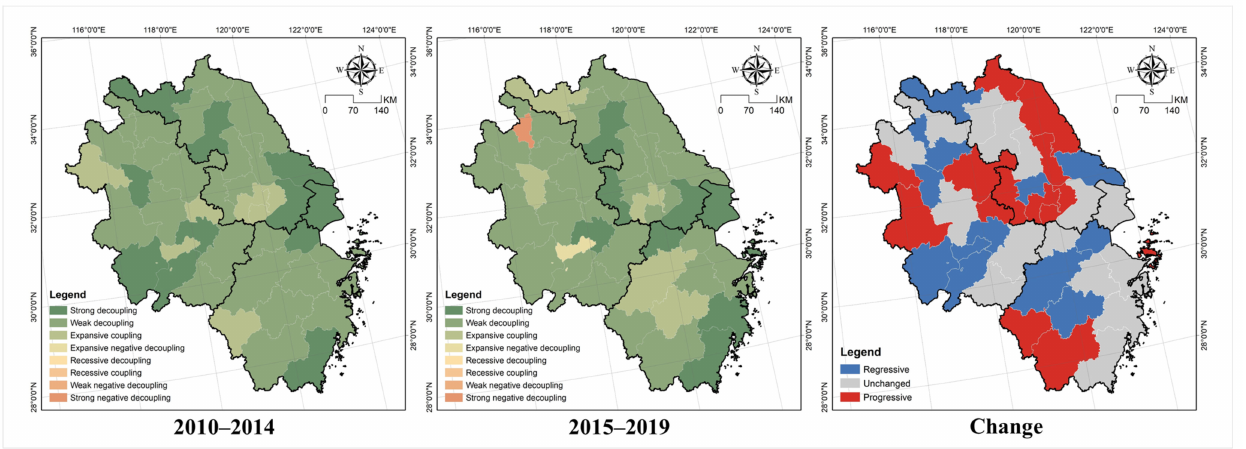
Figure 10. Spatial analysis of the decoupling relationship between urban industrial land and added value in Yangtze River